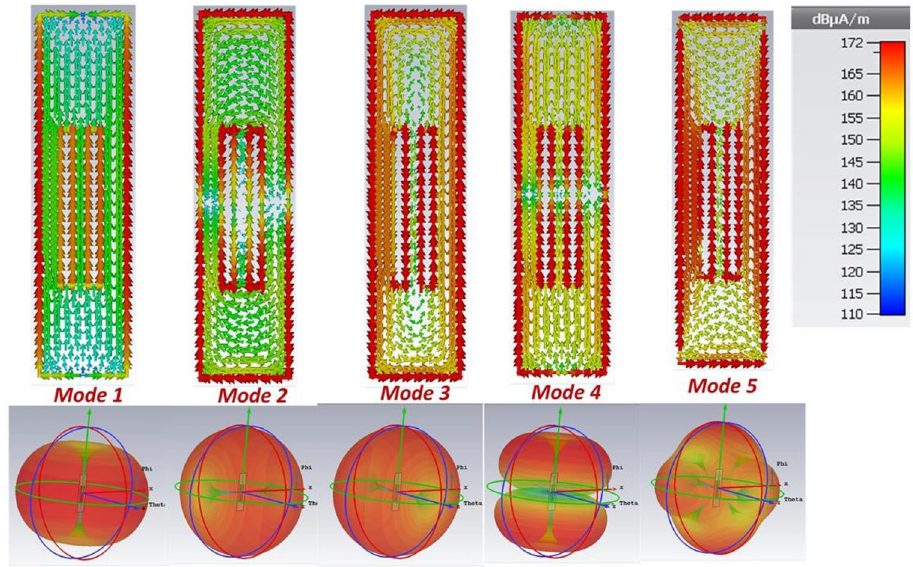
Figure 4. Current distribution and far-field associated with five modes of proposed tag antenna in free space.